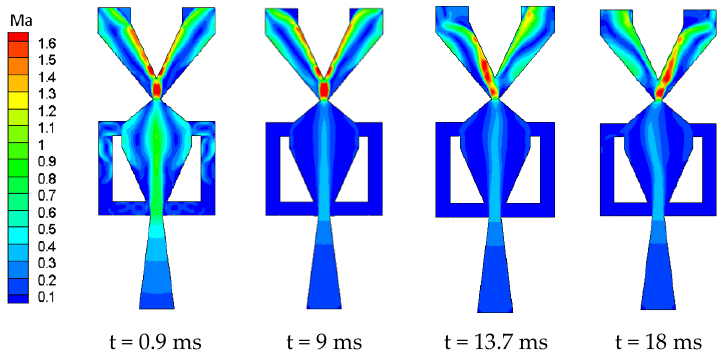
Figure 5. Mach number distribution at different times in model M 5, 3.